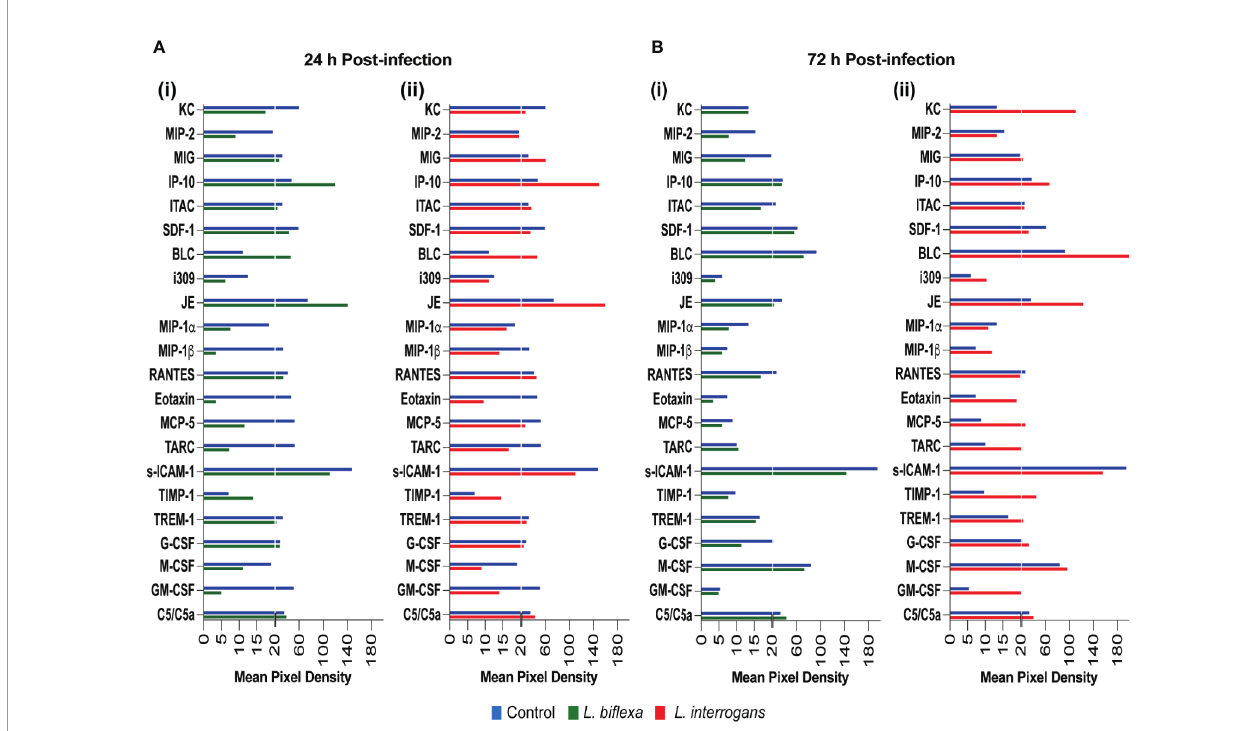
FIGURE 2 | Proteome pro fi ling of chemokines circulating in serum from mice infected with L. interrogans, L. bi fl exa and PBS controls. Detection of chemokine proteins in pooled serum (n=4 mice), represented as mean pixel density at 24h (A) and 72h (B) post infection. Sub-panel (i) depicts representative graphs of L. bi fl exa vs control, whereas (ii) depicts L. interrogans vs control. The chemiluminescence was measured and the mean pixel density value was determined using ImageJ software. The values were normalized by subtracting the background of 3 membranes for each exposure for a total of 3 exposures. Data represents the average pixel density between the two spots for each immune marker after subtraction of the normalized